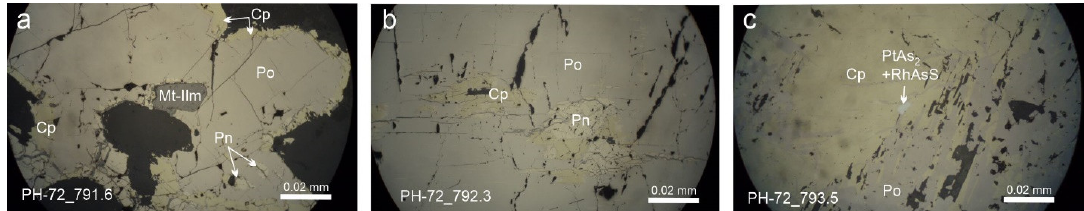
Figure 8. Microparageneses of the minerals in the exocontact vein-disseminated ores: ( a ) pyrrhotite grain in intergrowth with chalcopyrite (Cp), pentlandite (Pn) and magnetite-ilienite- (Mt-Ilm) inclusion; ( b ) pyrrhotite-chalcopyrite-pentlandite grain; ( c ) pyrrhotite-chalcopyrite grain with PGM inclusion (PtAs 2 +RhAsS).